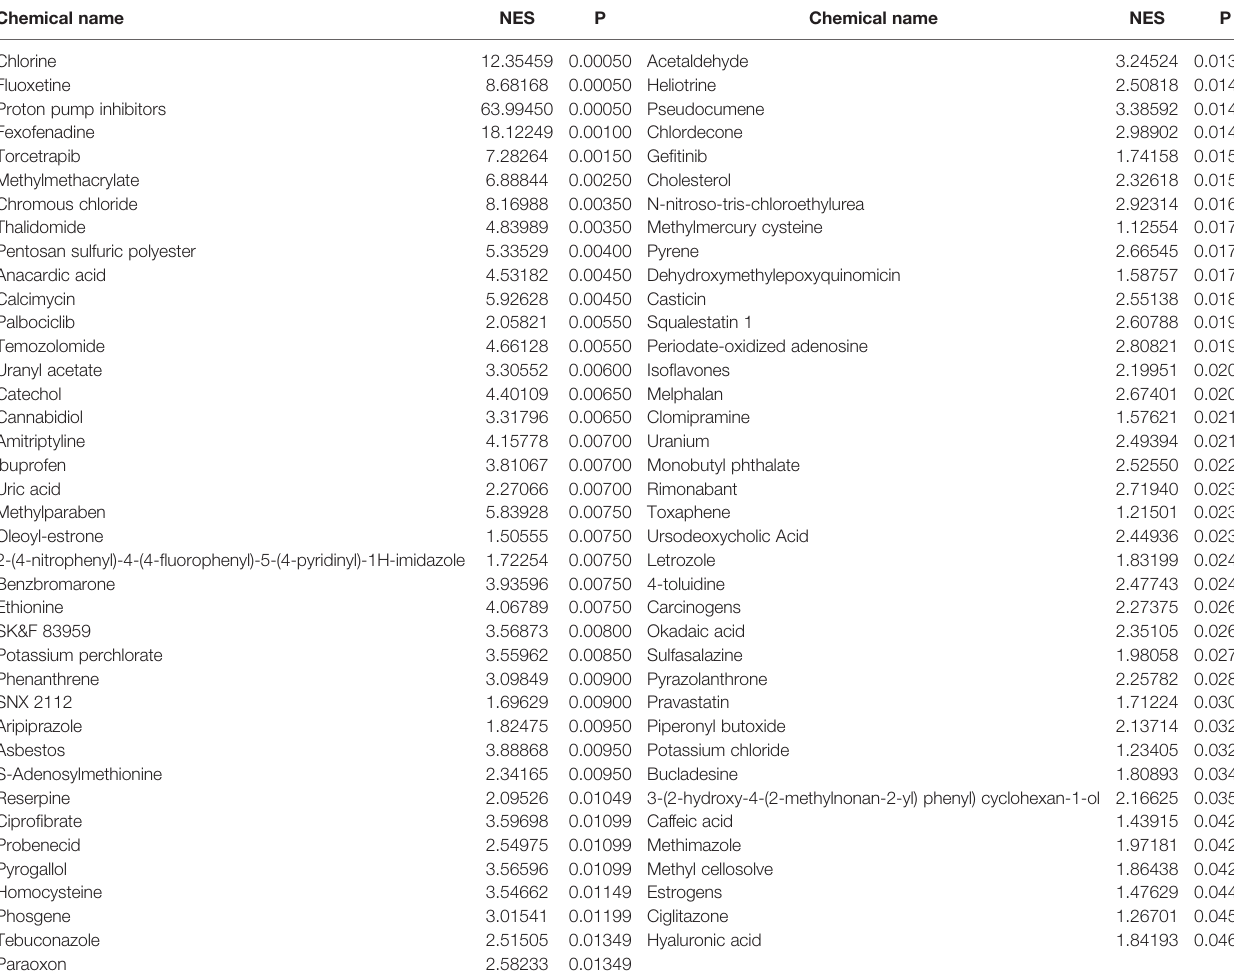
TABLE 2 | Signi fi cant chemicals identi fi ed by CGSEA of the signi fi cant TWAS-identi fi ed AAM-associated